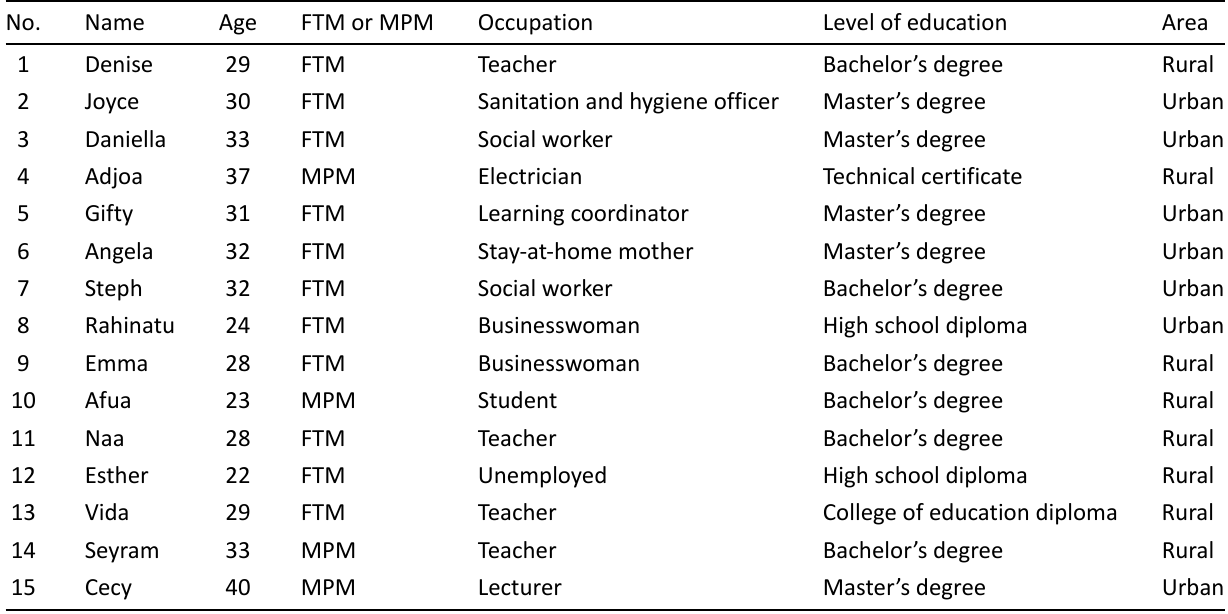
Table 1. Research sample demographics.